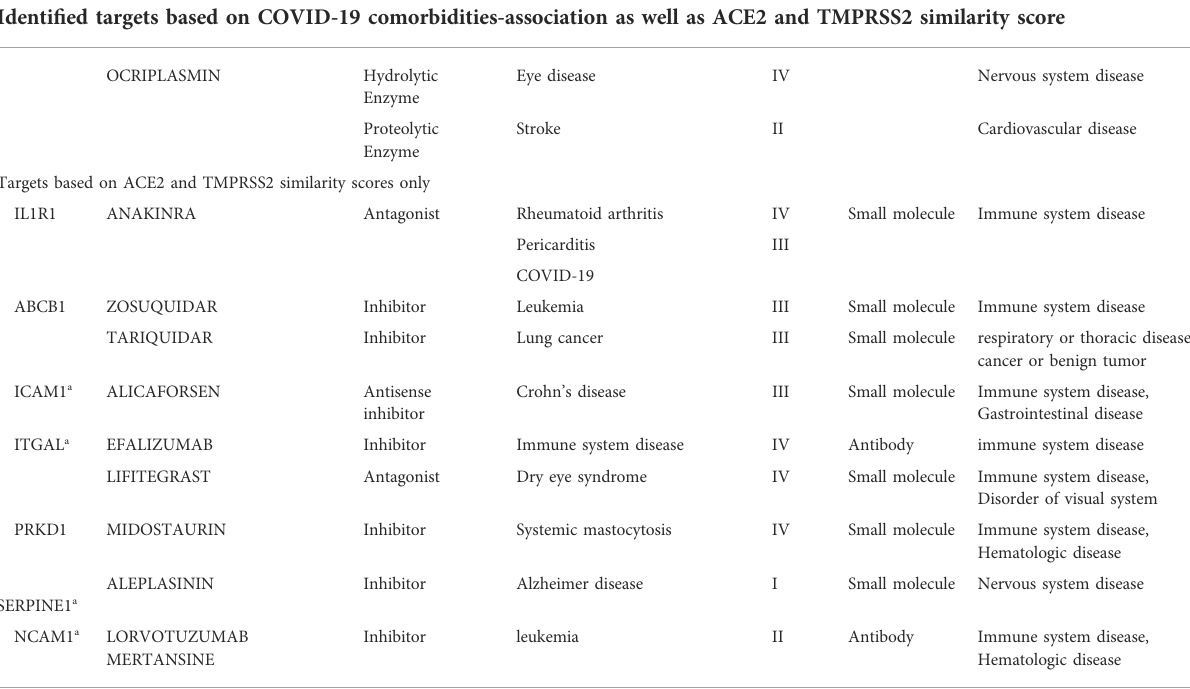
comorbidities and ACE2 and TMPRSS2 similarity scores, 17 drug target genes were identi fi ed, Marketed drugs for identi fi ed genes are indicated for the treatment of hypertension, heart failure, kidney failure, lung cancer, diabetes mellitus, emphysema, pulmonary obstruction, acute coronary syndrome, allergic rhinitis, in fl ammation, diabetic foot fever, diabetes mellitus, rheumatic disease and generalized lipodystrophy (Table 1). Identi fi ed drugs could be tested further for repurposing to reduce the severity risk among COVID-19- infected patients. Drug repurposing of marketed or approved drugs is an effective alternative method to uncover new indications rapidly.